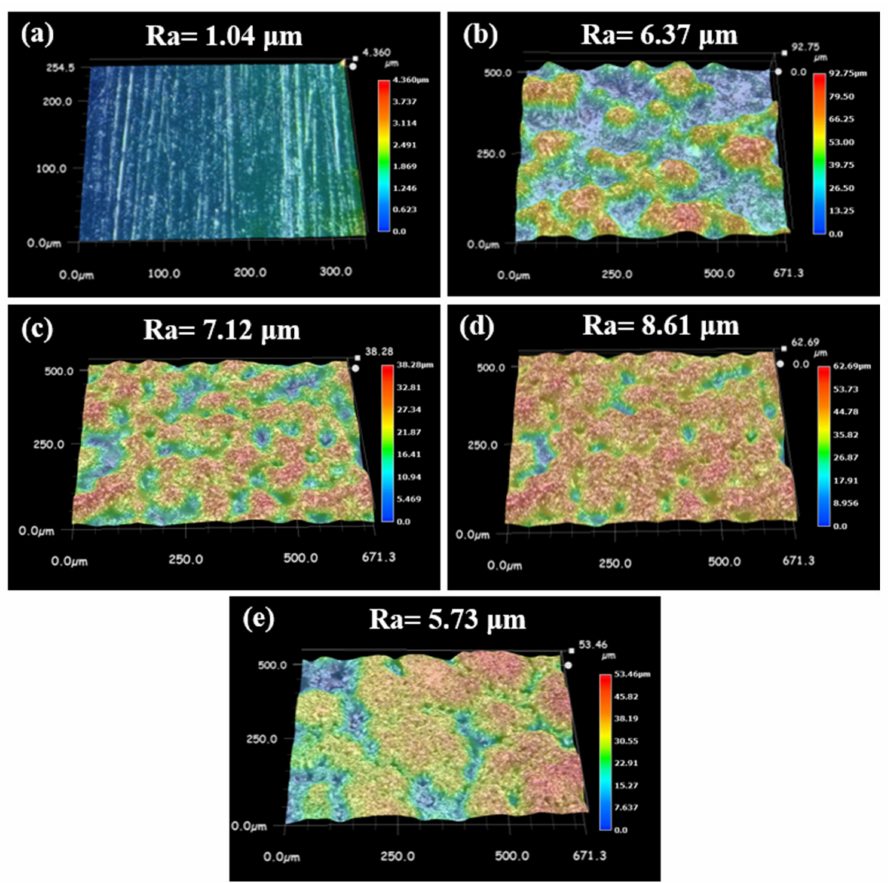
Figure 12. The 3D profile and surface roughness average (Ra) of the Ni-Co/WS 2 nanocomposite coatings prepared with different concentrations of WS 2